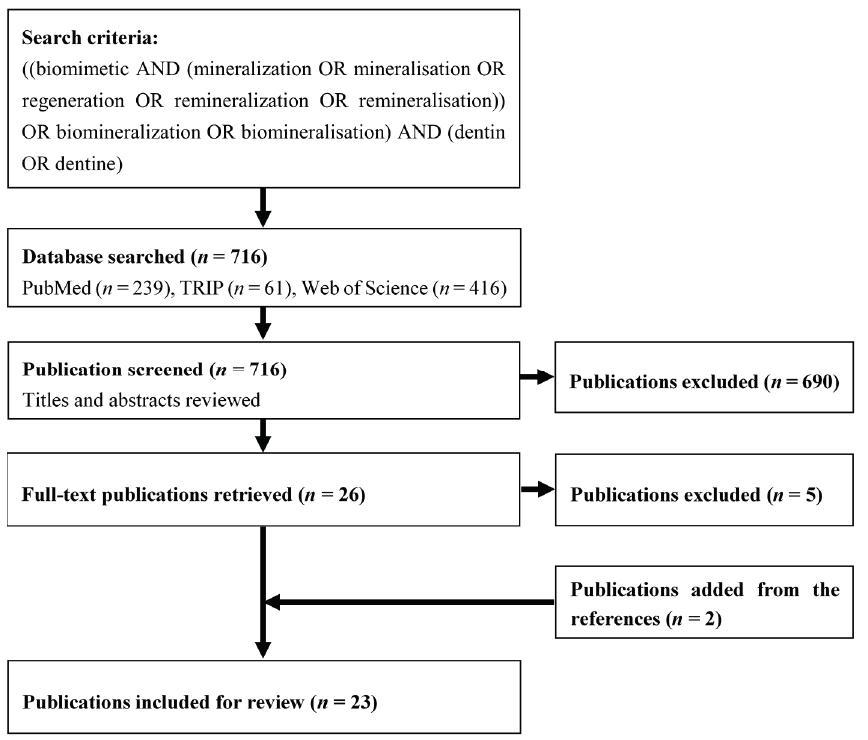
Figure 1. Flowchart of the search